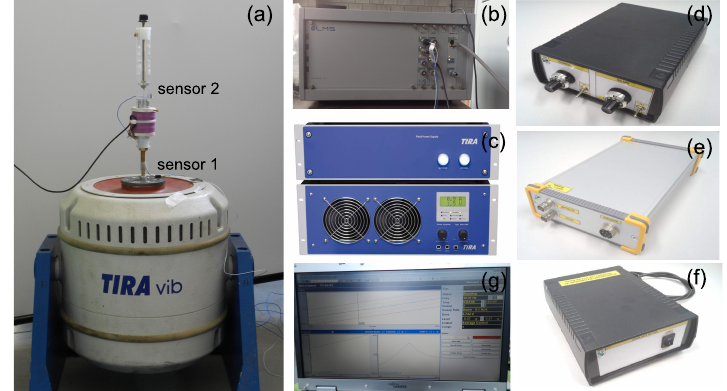
Figure 5. Measuring stand: shaker TIRA vib 50101 with the harvester ( a ), the LMS SCADAS module ( b ) with the analogue TIRA amplifiers ( c ), the load resistance module ( d ), the harvester DSP module ( e ), the harvester amplifiers ( f ) and the PC with the TestLab software ( g